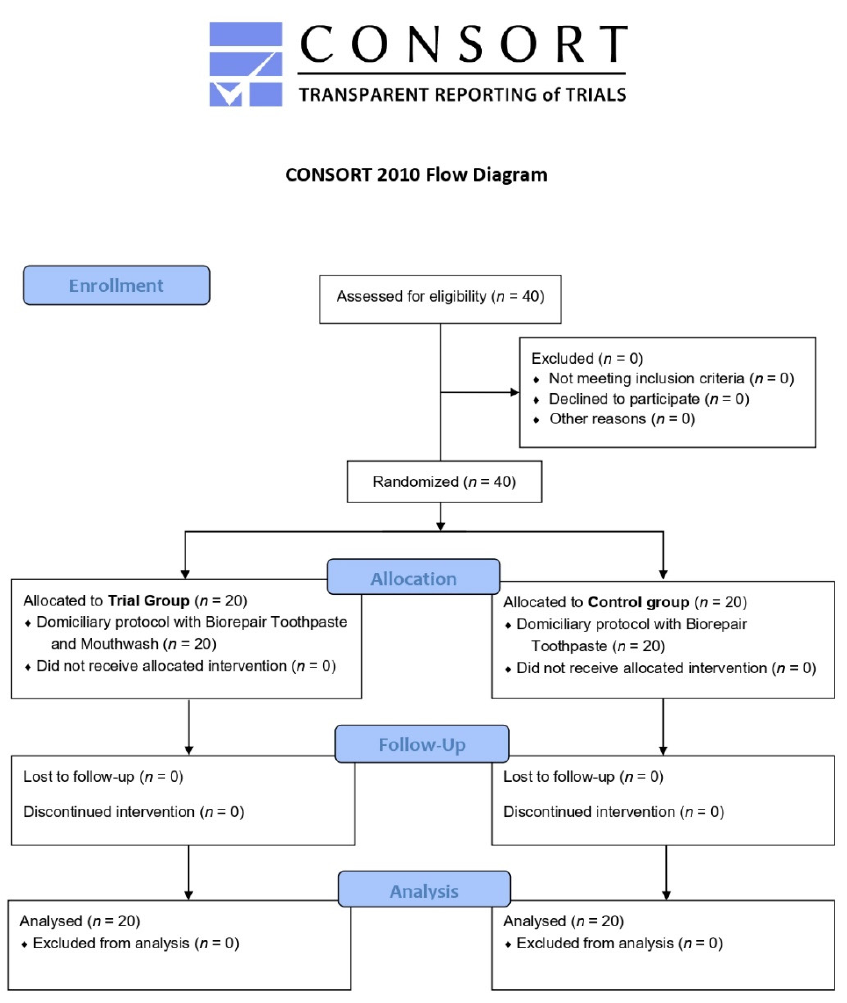
Figure 1. CONSORT flow chart of the